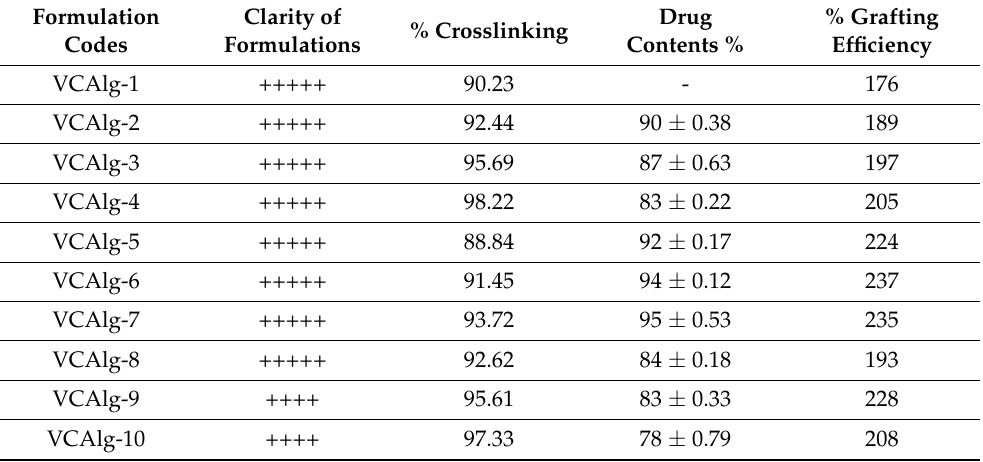
Table 2. % crosslinking, % drug contents extracted, % grafting efficiency, and clarity of formulations.